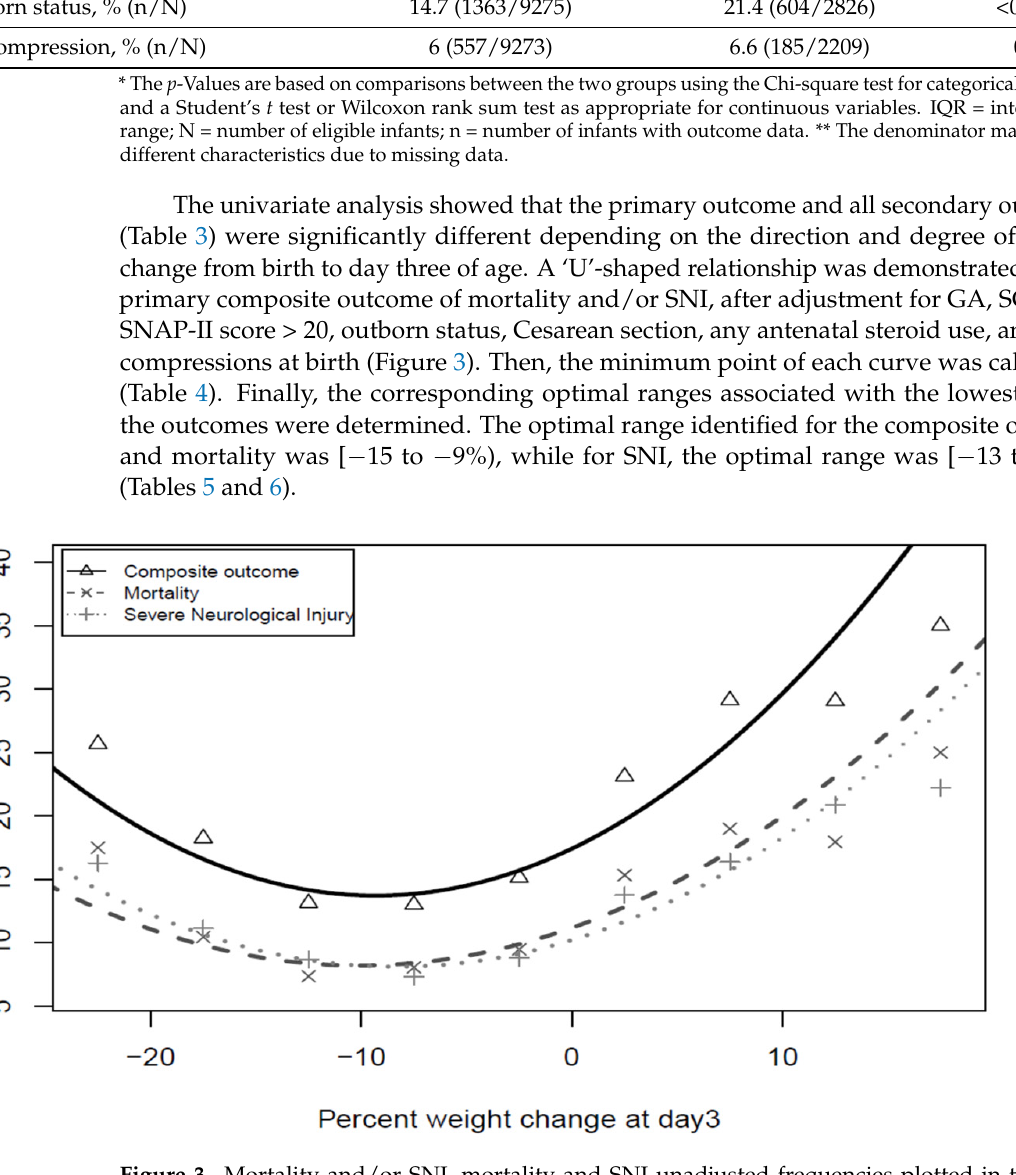
Figure 3. Mortality and/or SNI, mortality and SNI unadjusted frequencies plotted in the fitted quadratic curve. Table 1. Comparison of maternal and neonatal characteristics among the groups of weight change (% of birth weight) between birth and day three.